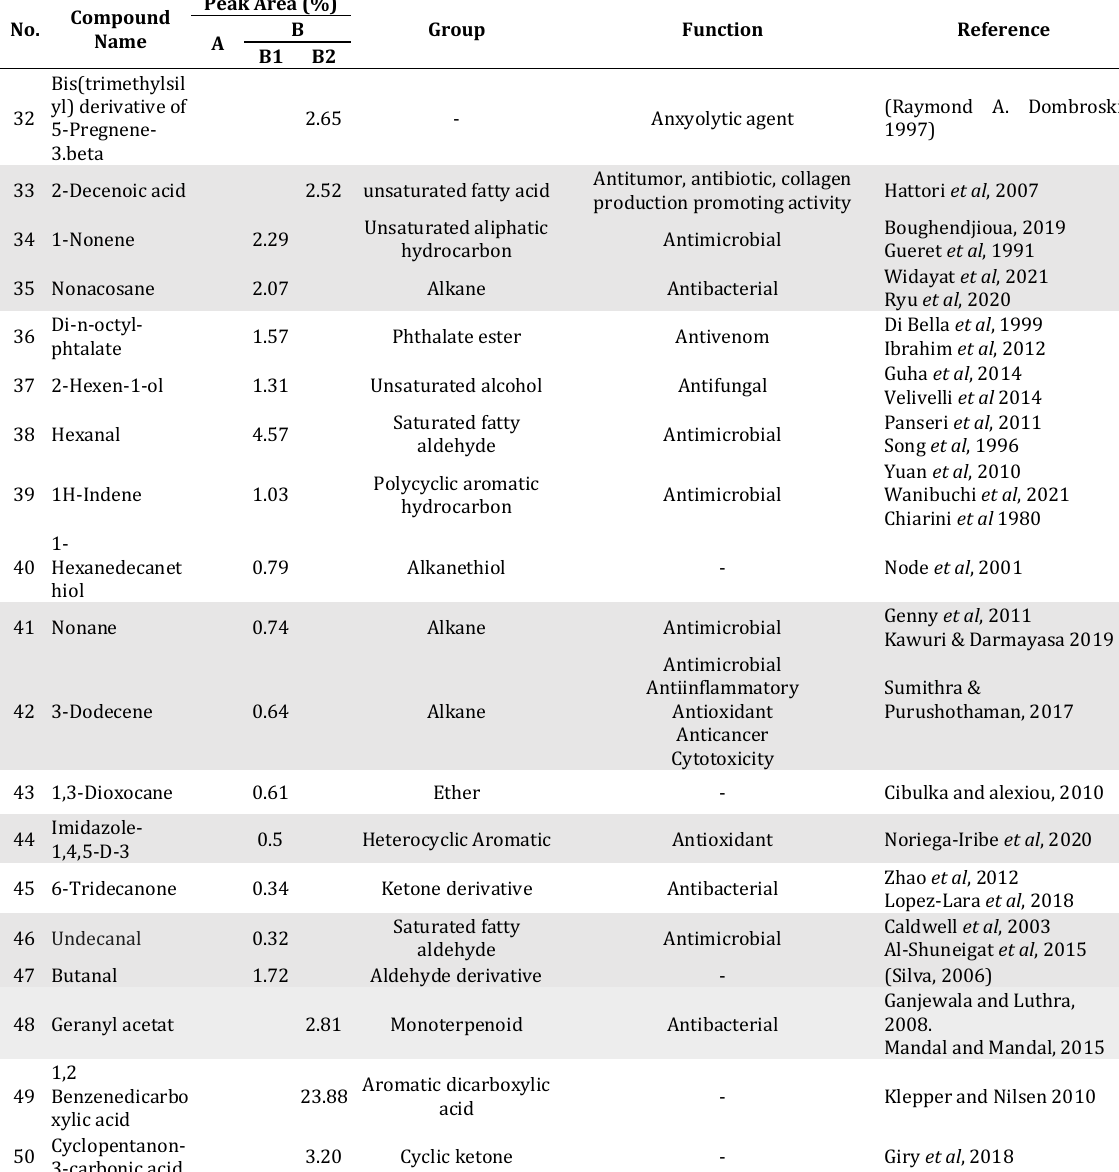
Table Ib. Profile of bioactive compound of control and treatment Callus (Without and With Preservation)